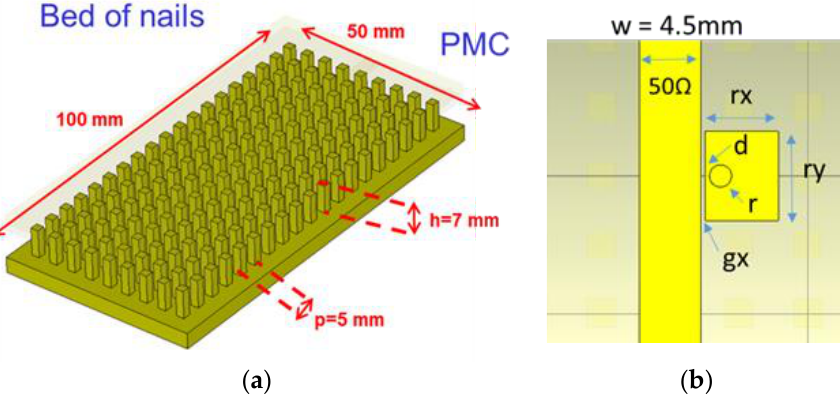
Figure 4. Truncated bed of nails for analysis and main parameters for the EBG resonator: ( a ) array of pins ( b ) EBG resonator in coplanar configuration and geometrical parameters.